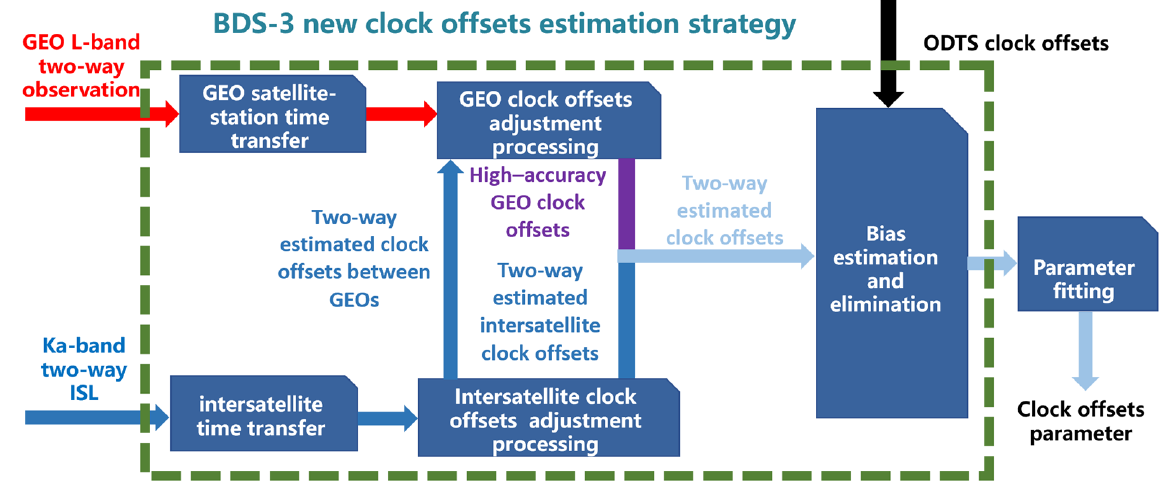
Figure 4. The procedure of the BDS-3 new clock offsets estimation strategy.